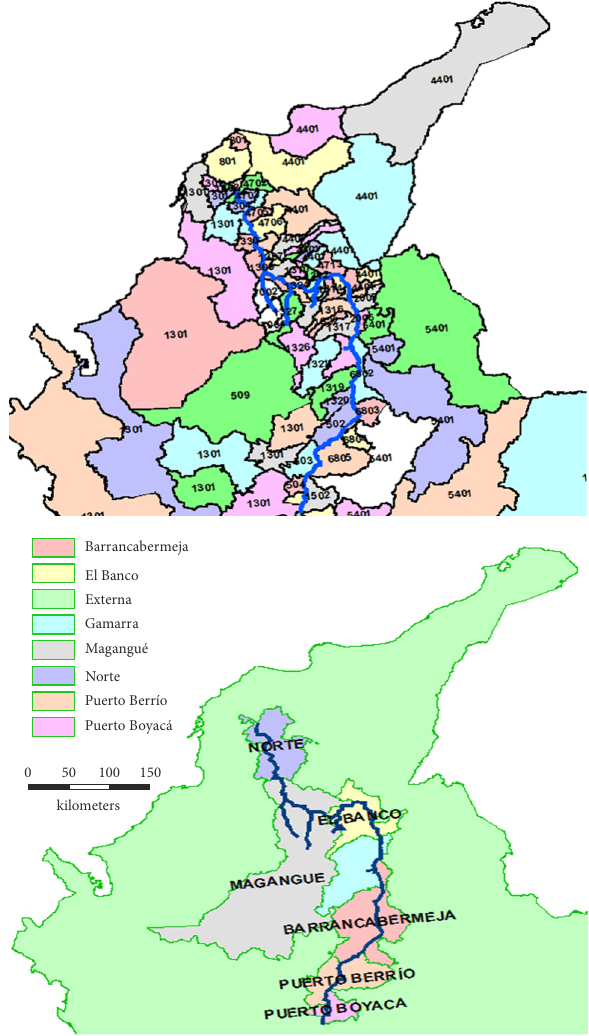
Figure 3. Detailed and aggregated zoning in